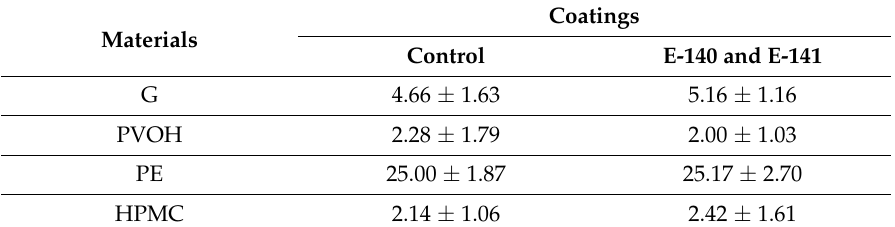
Table 3. Thicknesses ( µ m) of films and coatings with and without chlorophyllin.